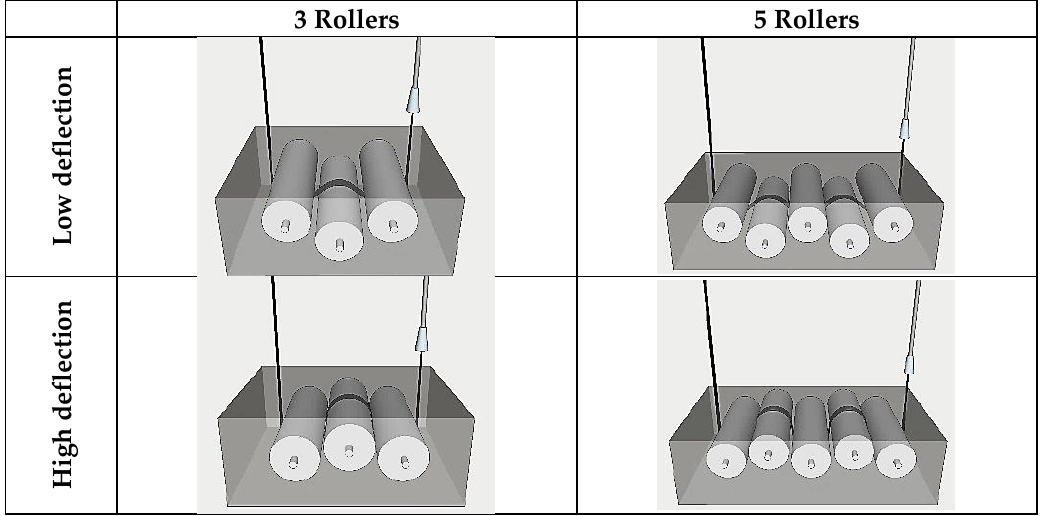
Figure 9. Schematic drawing of the roller assembly with low and high deflection of the yarn.